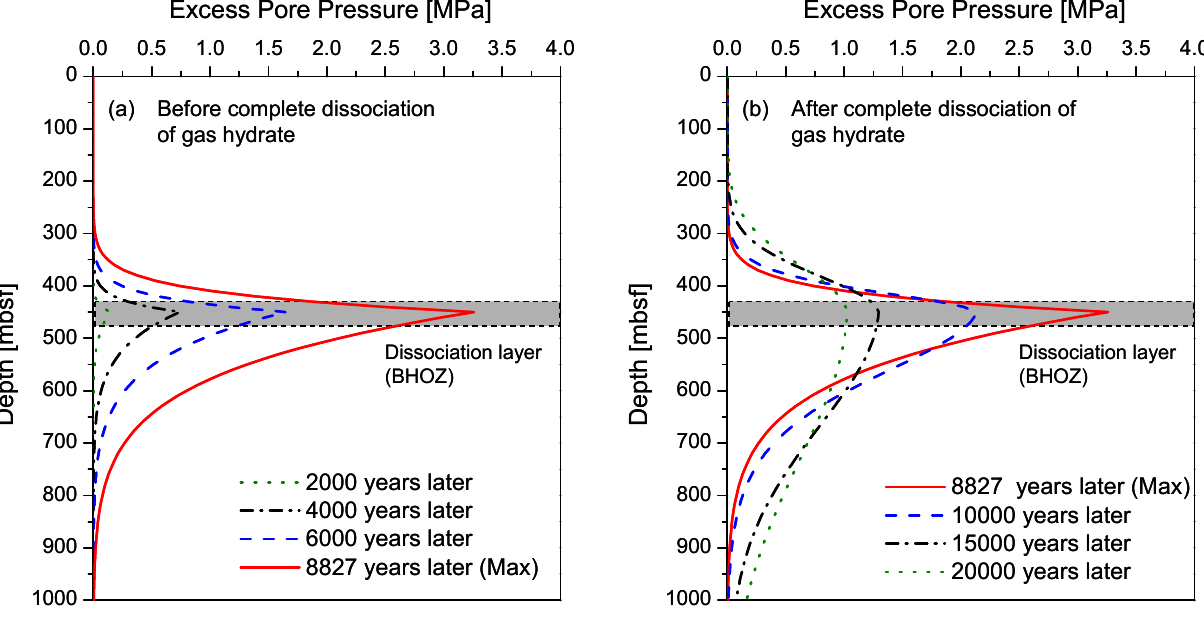
Figure 7. One-dimensional spatial distribution of excess pore pressure due to hydrate